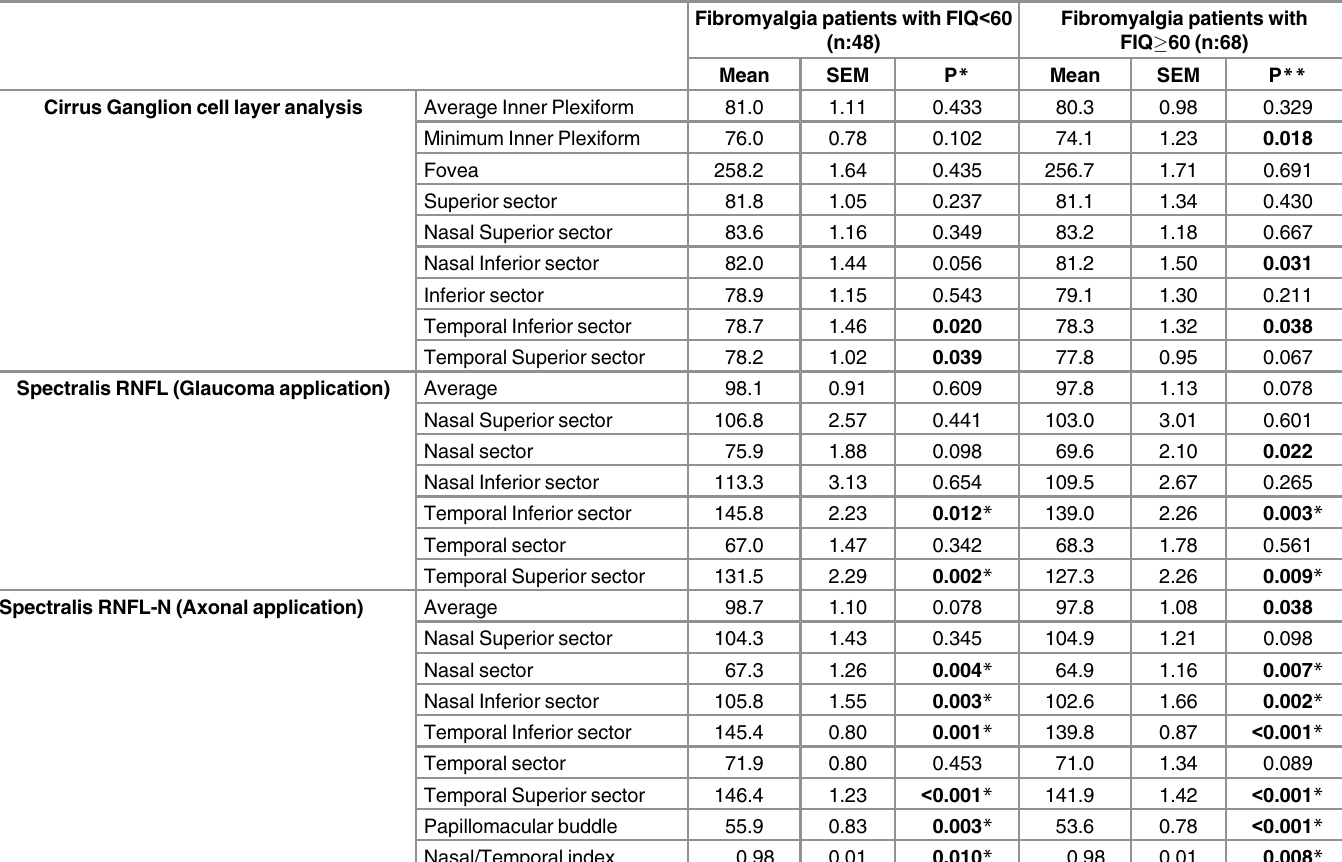
Table 3. Mean and standard error of the mean of retinal nerve fiber layer thicknesses obtained with the Cirrus and Spectralis optical coherence tomography devices in patients with early and advantage stages of Fibromyalgia syndrome and statistical significance with controls.